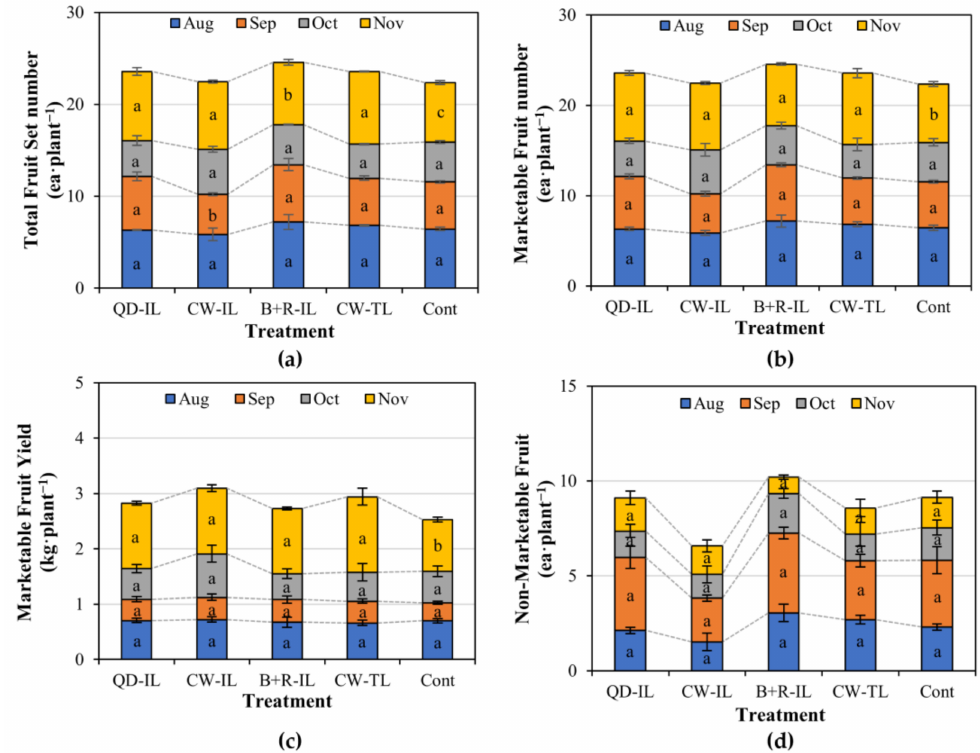
Figure 3. ( a ) Total fruit set number during supplemental lighting application. ( b ) Marketable